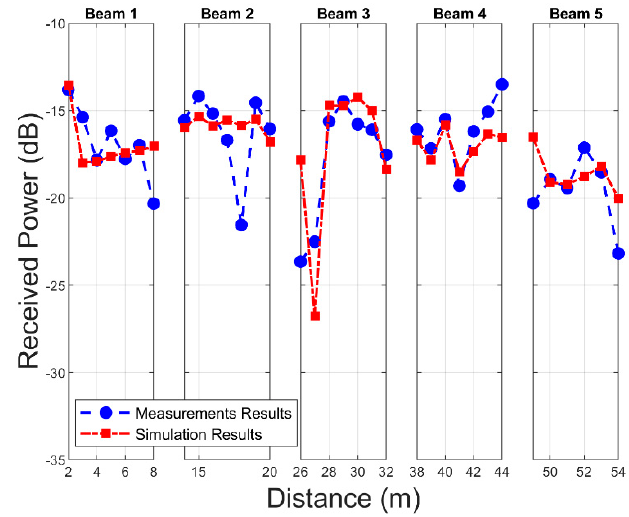
Figure 10. Measurement results for Beam 1 to Beam 5 in the designated locations (see Figure 2 for reference), and 3D-RL simulation results for these spatial positions.